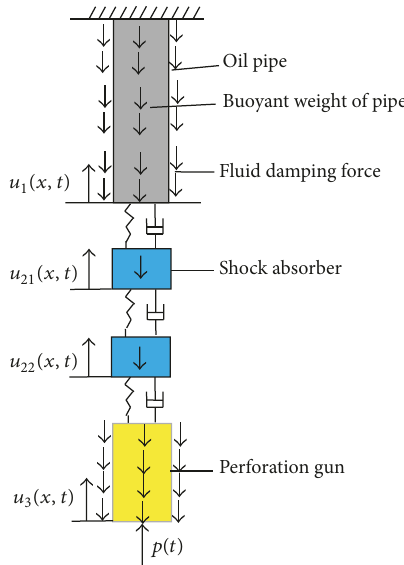
Figure 3: Mechanical model of oil tube-shock absorber-perforating